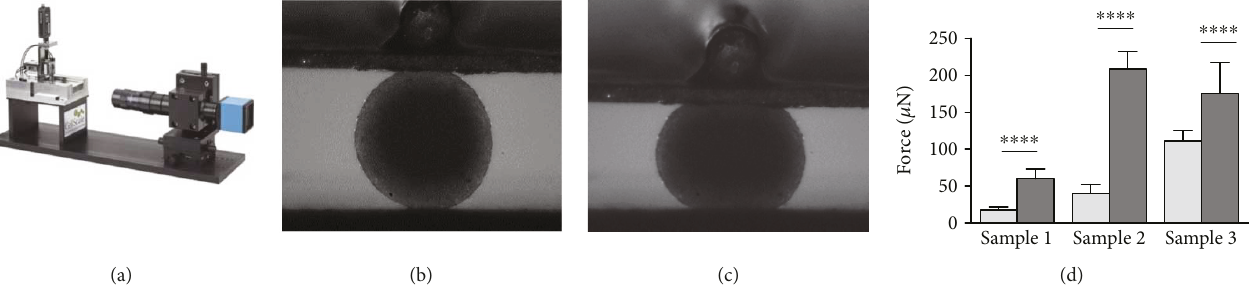
Figure 5: The CPC spheroids formed in the hydrogel with 800 μ m diameter in each circular recesses show enhanced resistance to compression after spontaneous chondrogenesis (21-day culture) compared to those cultured for 2 days (spheroids compaction). (a) Equipment used to perform the loading tests. (b, c) One CPC spheroid between 2 plates before and after compression, respectively. Note spheroid deformation of 25% of the original diameter in (c). Five compression cycles were performed, with a load phase duration of 20 seconds and a recovery phase of 10 seconds. (d) Data collected from 3 spheroids of three di ff erent samples after spheroid compaction (2 days, light gray column) and after spontaneous chondrogenesis (21 days, dark gray column) are expressed as mean ± SD. ∗∗∗∗ p < 0 0001